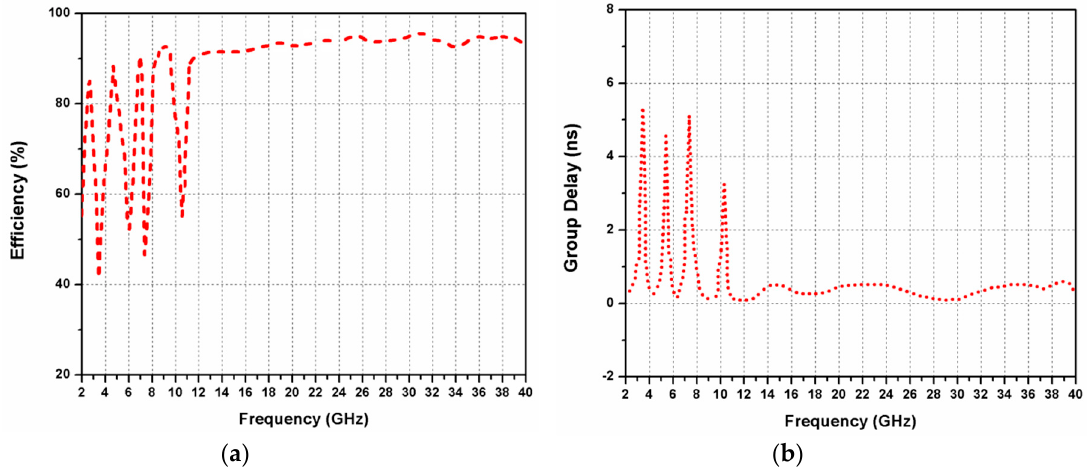
Figure 10. Proposed quadruple band-notched SWB antenna: ( a ) efficiency, ( b ) group delay.